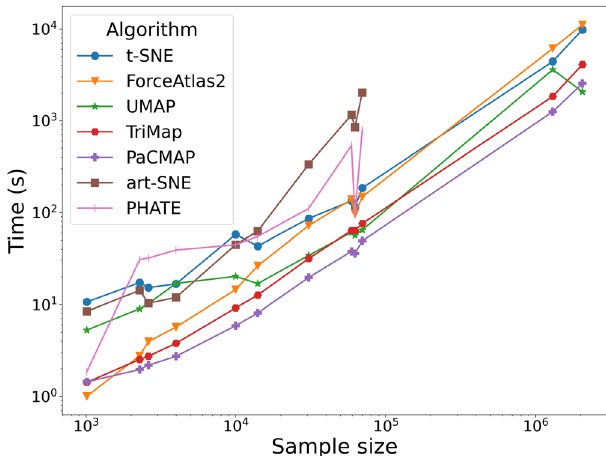
Fig. 8 Running time comparison. For each algorithm, the running time is de fi ned as the time required to transform the pre-processed dataset with shape N × d into a low-dimensional embedding with shape N × 2, using the default convergence criteria for each algorithm. Therefore, for ForceAtlas2, the nearest-neighbor graph construction time is also included for